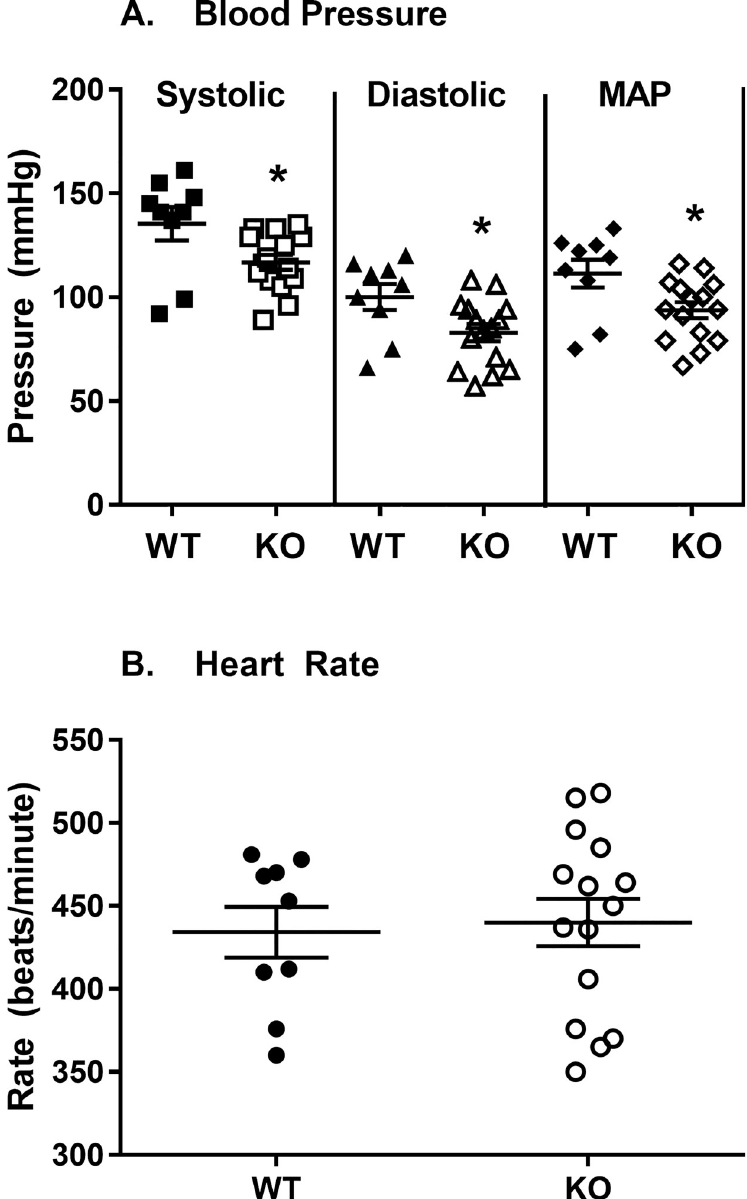
Fig 2. Haemodynamic measurements. Systolic, diastolic, mean arterial pressure (MAP) (Panel A), and heart rate (Panel B), were measured in anesthetized wild-type (WT) and Slc29a1 -null (KO) mice using the tail-cuff method. � Significant difference between wild-type and Slc29a1 -null mice for the indicated parameter (Student’s t-test for unpaired samples, two-tailed, P < 0.05).